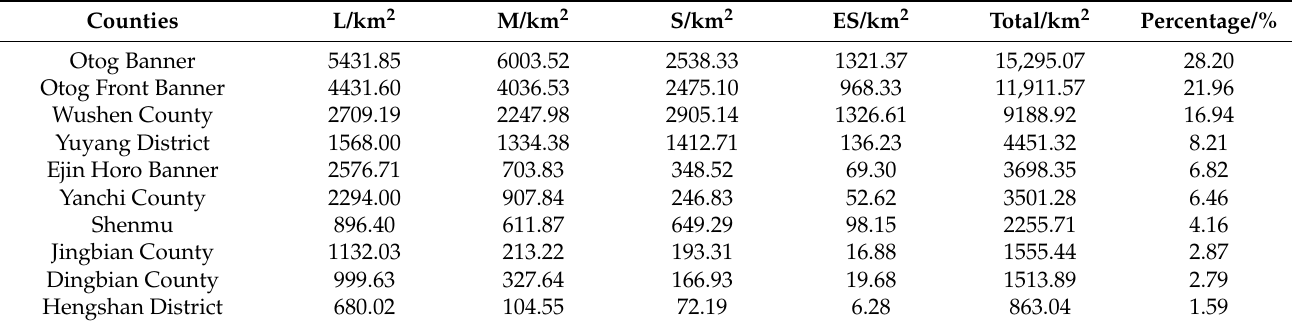
Table 6. Area of desertification land in various counties at different levels in